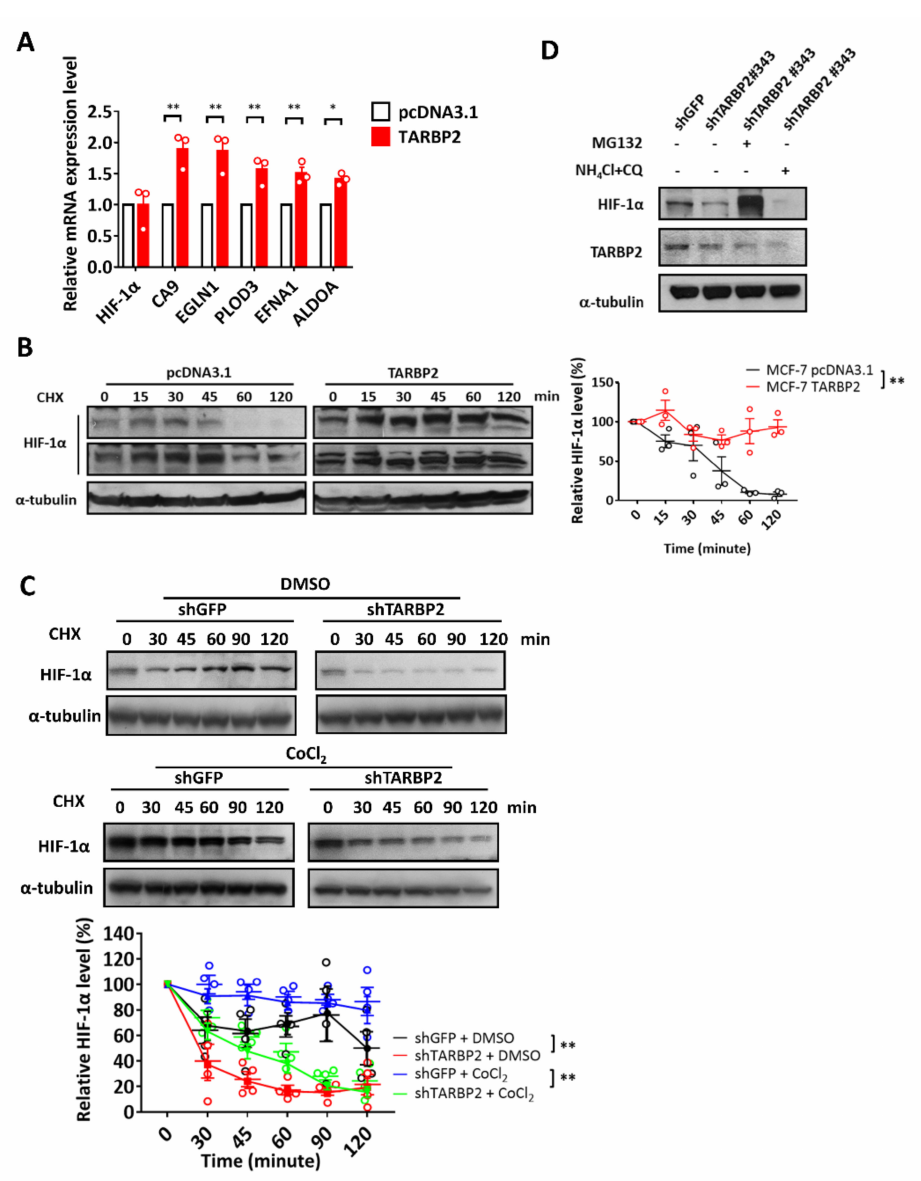
Figure 2. TARBP2 inhibits proteasomal degradation of HIF-1 α . ( A ) Relative mRNA expression of HIF-1 α and its downstream targets, including CA9, EGLN1, PLOD3, EFNA1 and ALDOA, in TARBP2- overexpressing MCF-7 cells were assessed using qPCR analysis. The stability of HIF-1 α protein expression in TARBP2-overexpressing MCF-7 cells ( B ) and CoCl 2 -treated TARBP2-overexpressing MDA-MB-231 cells ( C , D ) were investigated upon cycloheximide treatment and harvesting of the cells at the indicated time points. The western blot results from replicate experiments were quantified and analyzed using two-way ANOVA, p < 0.01. ( D ) TARBP2 knockdown MCF-7 cells were treated with MG132 or NH 4 Cl/CQ for 24 h to inhibit the proteasomal or lysosomal degradation pathways, respectively. * p < 0.05, ** p <